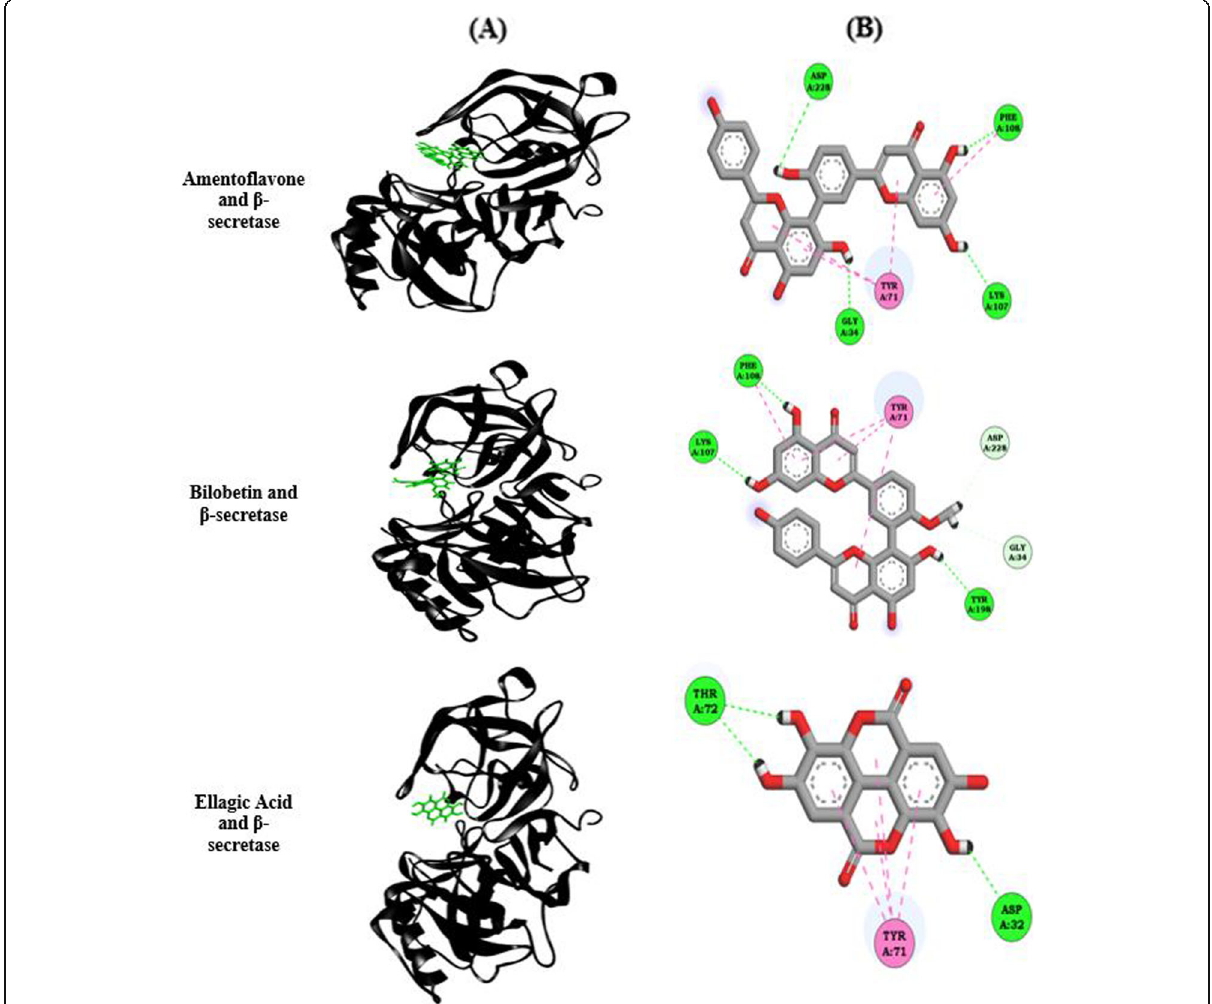
Fig. 3 a Three-dimensional representation of best possible poses of ligand molecules (green, stick) inside the binding pocket of β -secretase (black, ribbon). b Two-dimensional representation of ligand – receptor interaction. Interacting amino acids are represented in a three-letter code and their respective number in specific chain inside disc. Dotted lines represent type of interactions; green: conventional hydrogen bond; light green: carbon hydrogen bond. Pink: Pi – Pi stacked and Pi – Pi